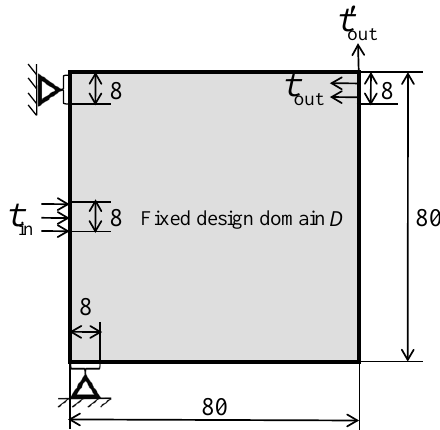
Figure 2. Fixed design domain and boundary conditions of model